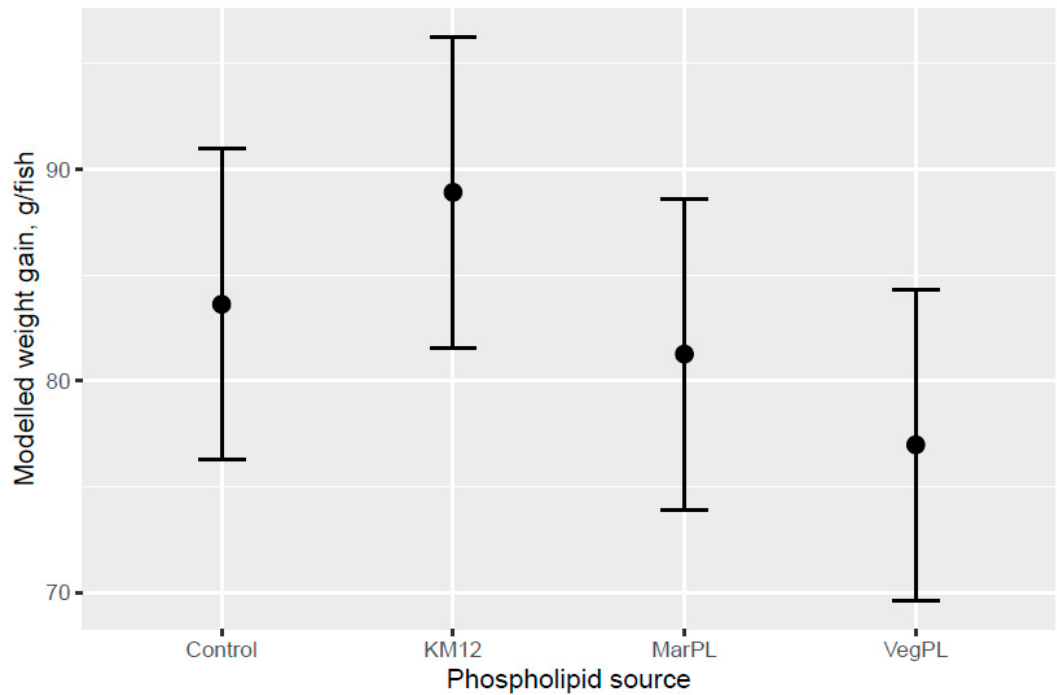
Figure 5. Modelled weight gain for feeding diets with different phospholipid sources after 53 d of feeding in the freshwater pre-transfer phase plotted with 95% credible intervals. Dots denote observed tank mean weight gains.